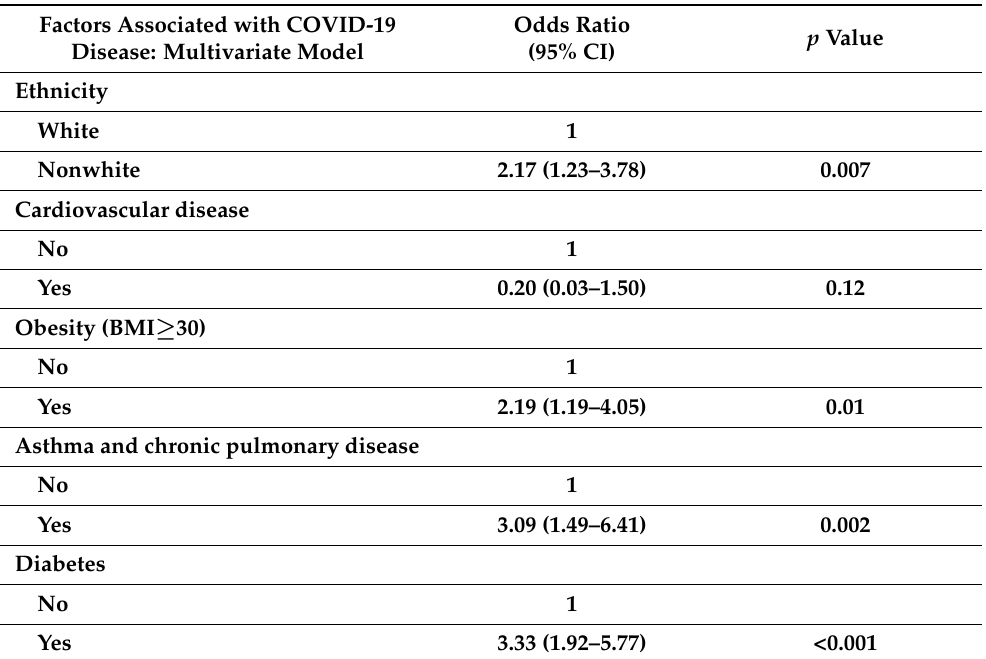
Table 2. Baseline factors associated with higher incidence of COVID-19 disease in kidney transplant patients according to the French study